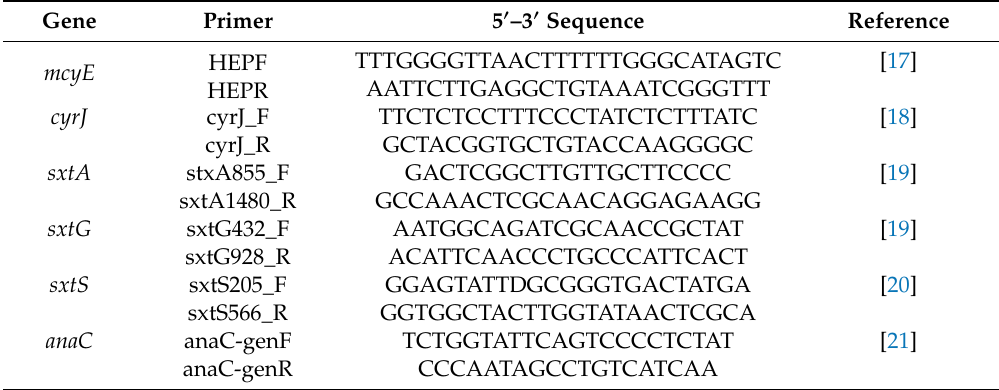
Table 1. List of primers used for qualitative polymerase chain reaction (PCR). Gene